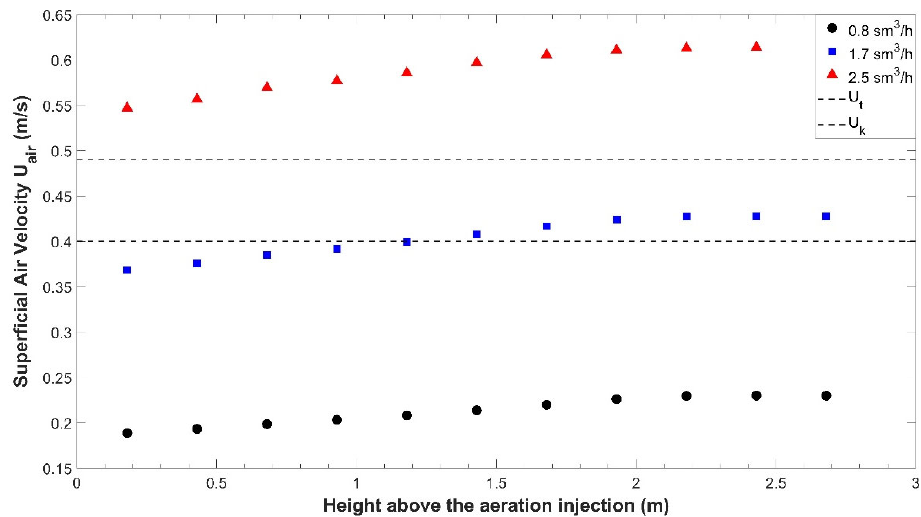
Figure 5. Increase of the superficial air velocity with the height in the tube, for three air flow rates, without particle circulation. The dashed lines correspond respectively to the turbulent and fast fluidization transition velocities determined with the standard fluidization column.